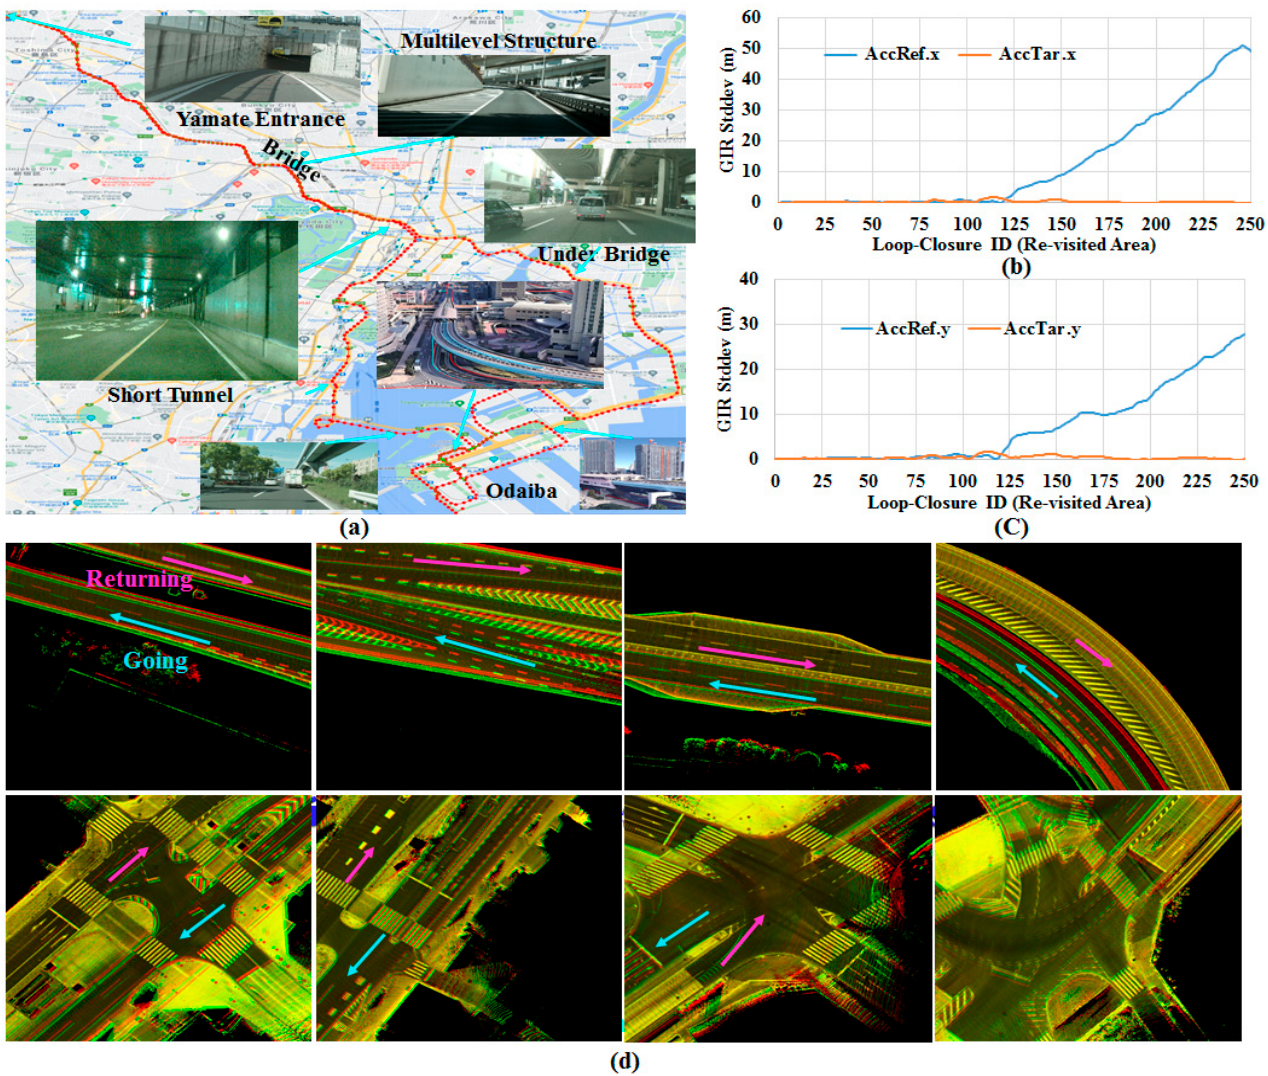
Figure 11. Mapping a critical environment simultaneously using two agents with the same driving scenario and sensor configuration. ( a ) Driving scenario by nodes from Odaiba area to the entrance of the Yamate Tunnel. ( b , c ) GIR accuracy in X and Y directions of the two agents. ( d ) GIR combined